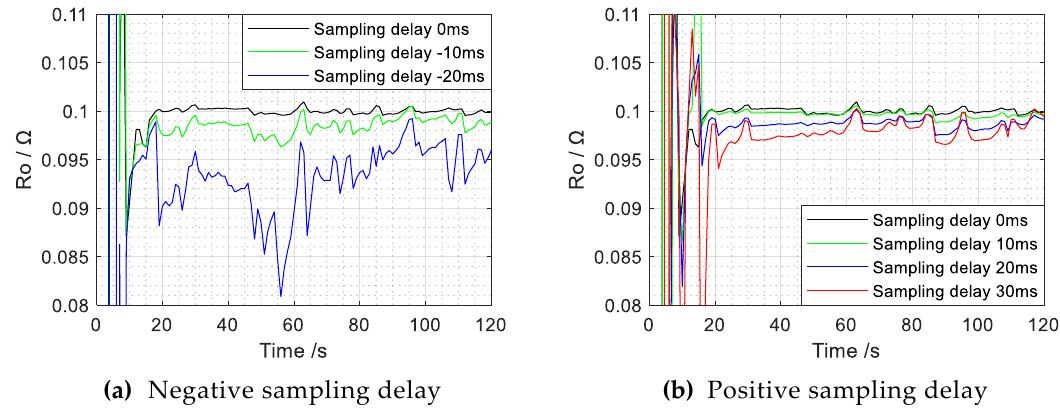
Figure 13. The trajectories of estimated internal resistance under larger sampling delays.